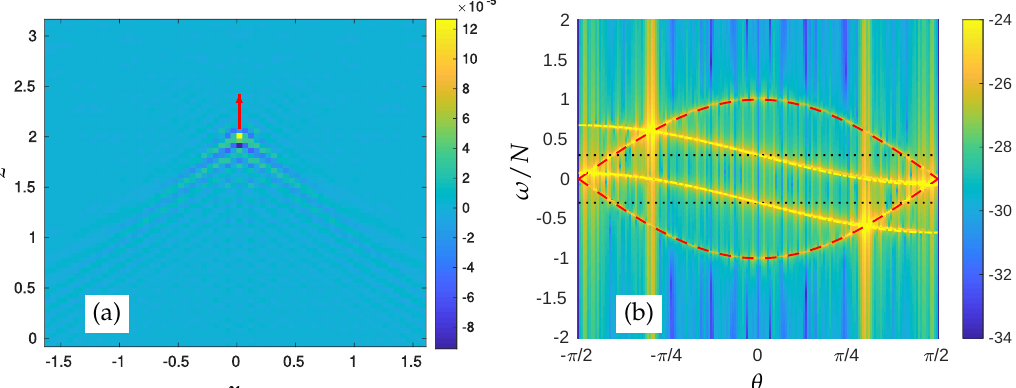
Figure 6. Doppler effect of an uniform motion of the source generating the internal gravity waves. ( a ) Vertical velocity u z in the ( x , z ) plane in physical space where the red arrow illustrates the vertical velocity of point forcing with c z = 6.28 × 10 − 3 (zoomed in). ( b ) The corresponding concentration of energy density E ( θ , ω ,56 < k < 60 ) in the ( θ , ω ) Fourier domain (in log scale). Red dashed line: dispersion relation curve ω r ( θ ) for internal gravity waves defined by Equation (2). Black dotted line: original forcing frequency ω f . Yellow dash-dotted line: modified frequency of the forcing with k = 60 given in Equation